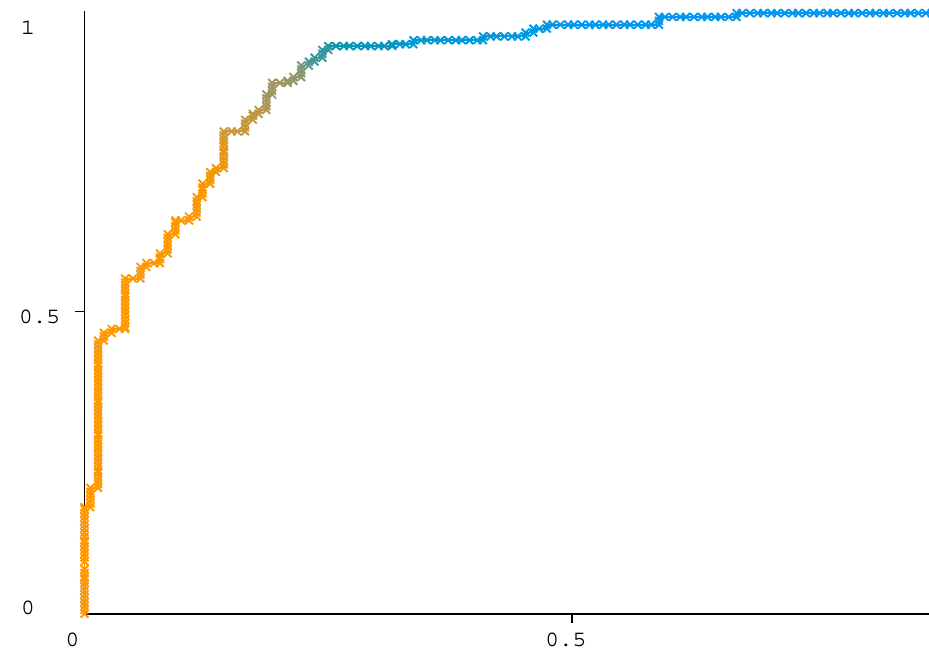
Figure 6. ROC curve of an NB classifier with a correlation-based feature selection set.